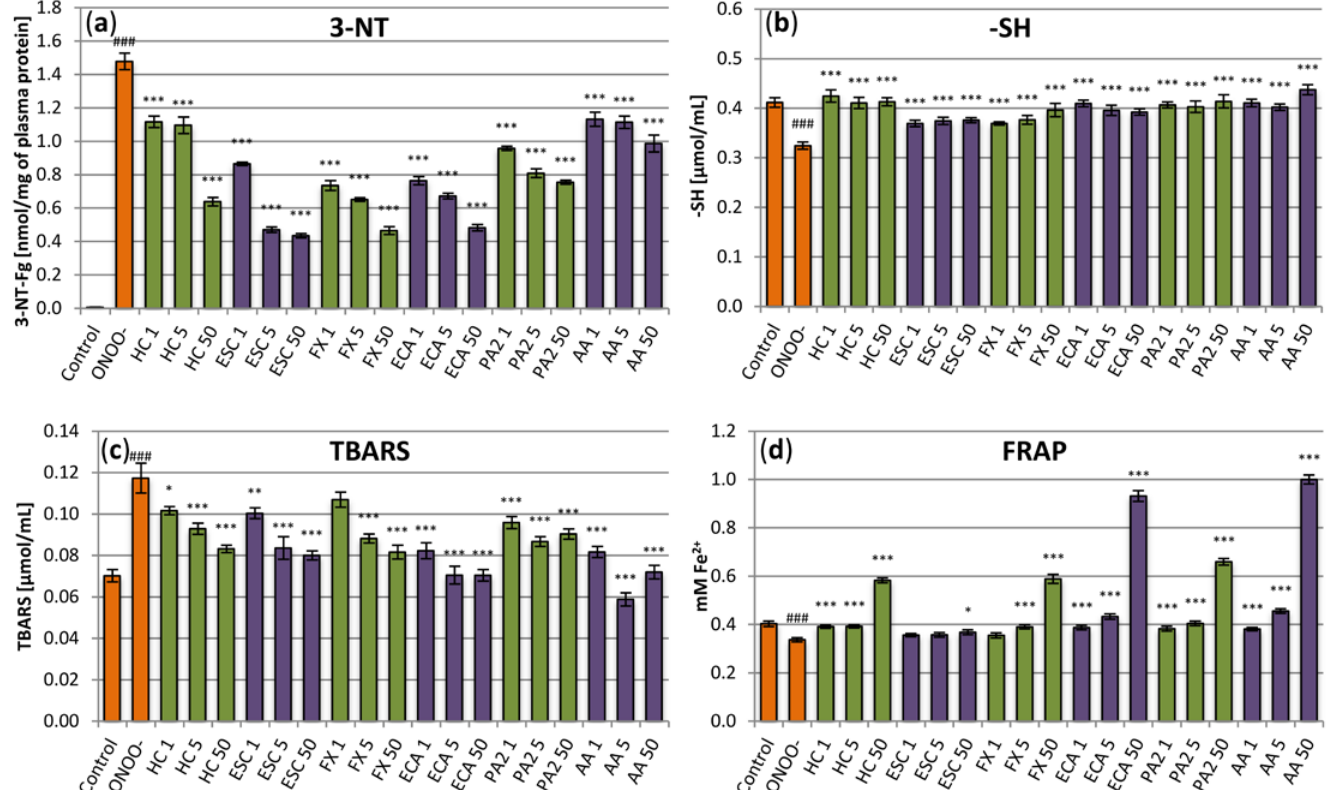
Figure 3. Effects of the investigated analytes on human plasma exposed to oxidative stress. ( a ) Effects on the nitration of plasma proteins assessed by the levels of 3-nirotyrosine (3-NT) and expressed as the 3-nitrotyrosine-containg equivalents (nmol of 3-NT-Fg/mg of plasma proteins); ( b ) effects on plasma protein thiol levels (-SH); ( c ) effects on the non-enzymatic antioxidant capacity (NEAC) of plasma, assessed by ferric reducing ability of plasma (FRAP); ( d ) effects on lipid peroxidation, assessed by the levels of thiobarbituric acid-reactive substances (TBARS). Results presented as means ± SE ( n = 9). Statistical differences: ### p < 0.001 for control plasma versus ONOO − -treated plasma (without the investigated analytes); * p < 0.05, ** p < 0.01, *** p < 0.001 for ONOO − -treated plasma in the presence of the analytes versus ONOO − -treated plasma without the analytes. Analytes: HC, horse-chestnut bark extract; ESC, esculin; FX, fraxin, ECA, (-)-epicatechin; PA2, procyanidin A2; AA, ascorbic acid; the numbers after analyte symbol indicate concentration in μ g/mL.